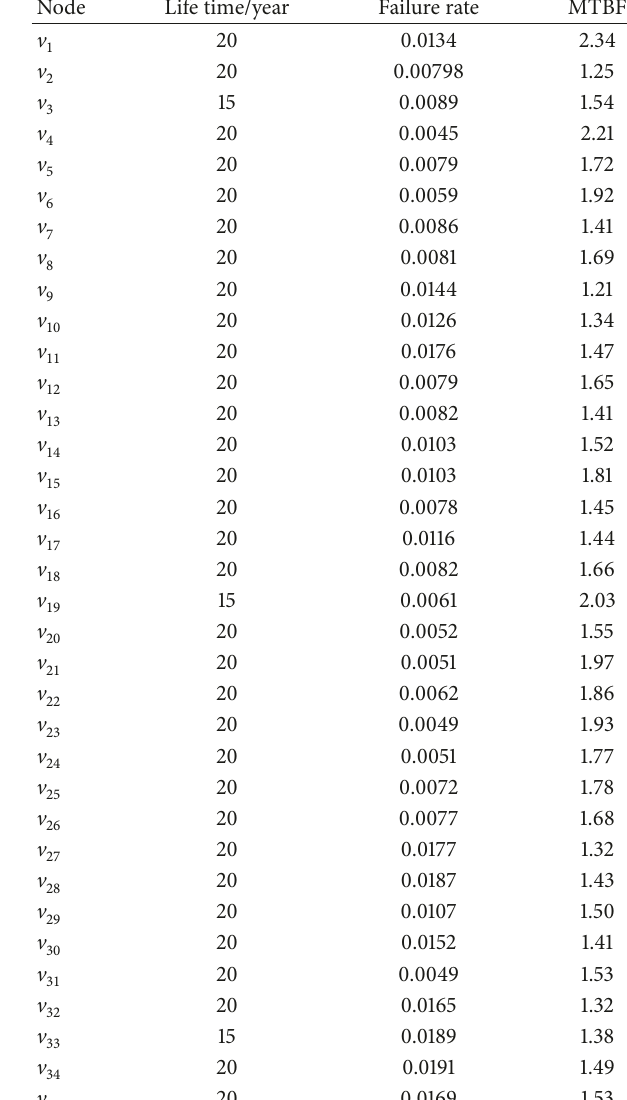
Table 2: The preprocessed failure data of gear box. Table 3: The nodes functional